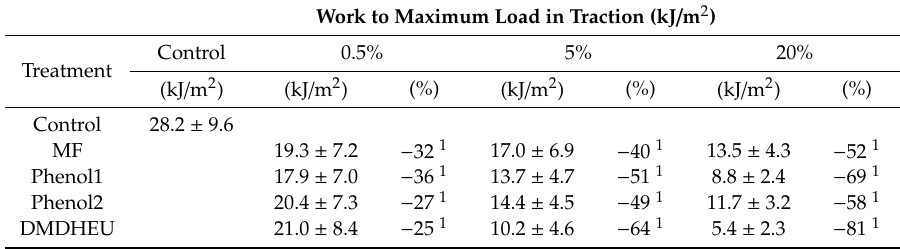
Table 7. Work to maximum load in traction (kJ/m²) and change compared to control (%) depending on the modification agent and the concentration (mean ± SD). Work to Maximum Load in Traction (kJ/m²)